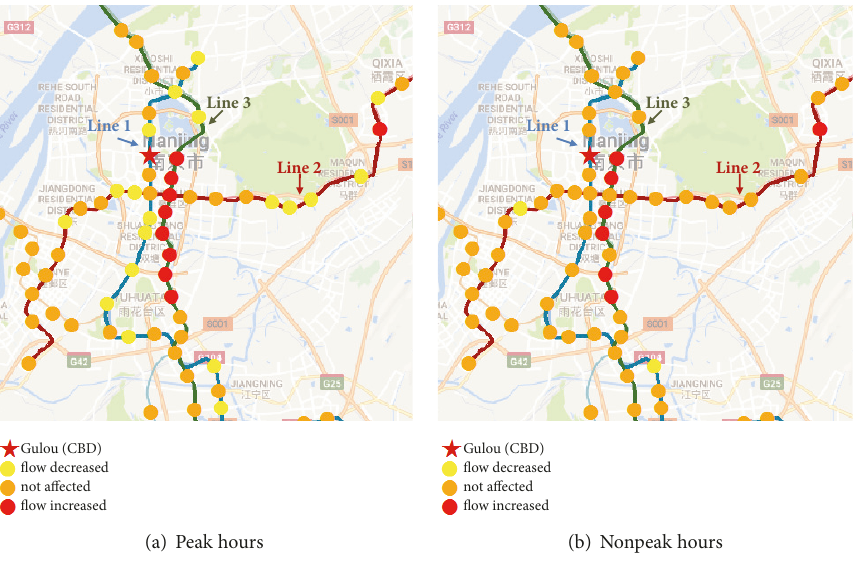
Figure 5: Change of passenger flow at metro stations after Line 4 opening (map source: Google Maps).